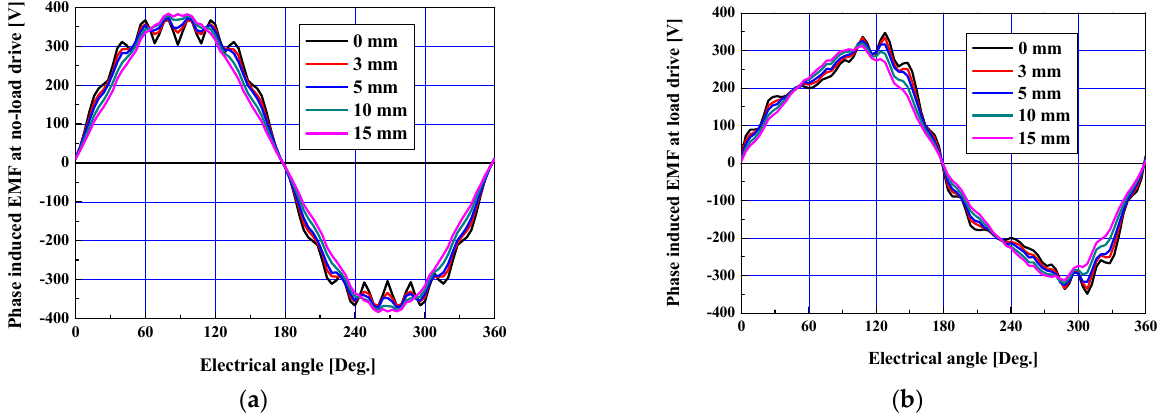
Figure 8. Wave form of the induced EMF according to the eccentricity with the slit: ( a ) no-load drive, and ( b ) load drive.